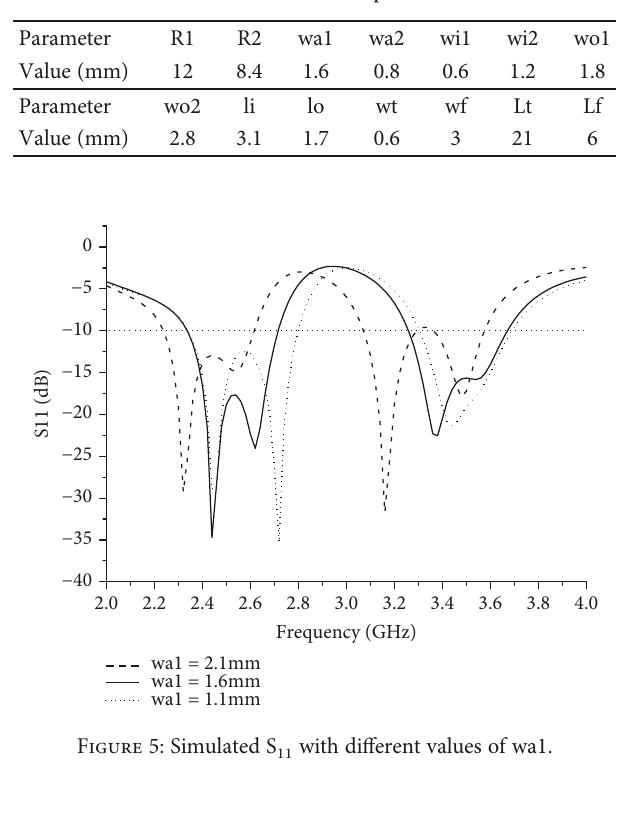
with di ff erent values of wa1. 11